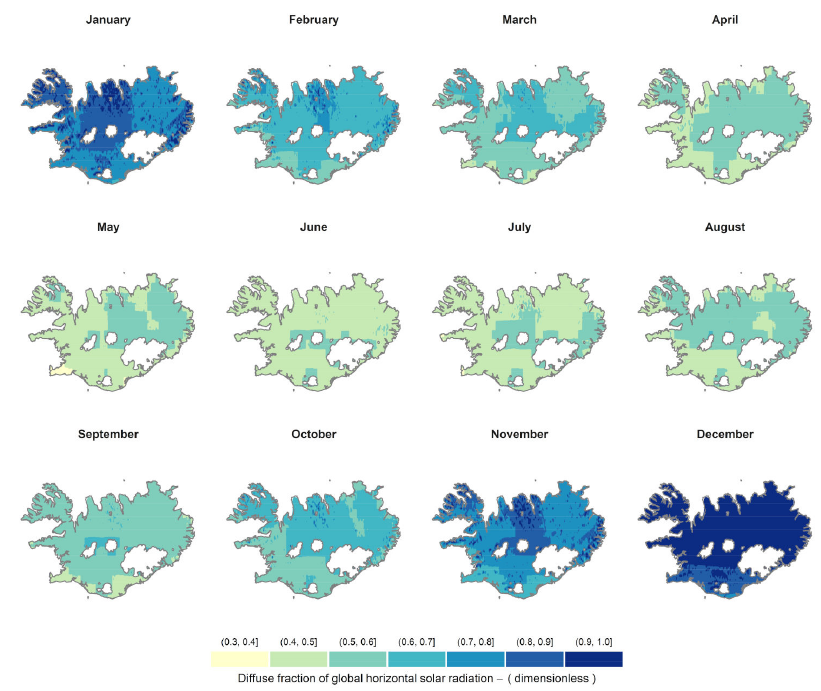
Figure A3. Monthly average diffuse fraction of global horizontal irradiance (G d /G h ) for Iceland. Values from the ECMWF-ERA-5 dataset with a coverage period of 2005–2016 retrieved from PVGIS as a 0.05 ◦ × 0.05 ◦ grid both in latitude and longitude, extending from 63 ◦ N to 67.5 ◦ N in latitude and 13 ◦ W to 25 ◦ W in